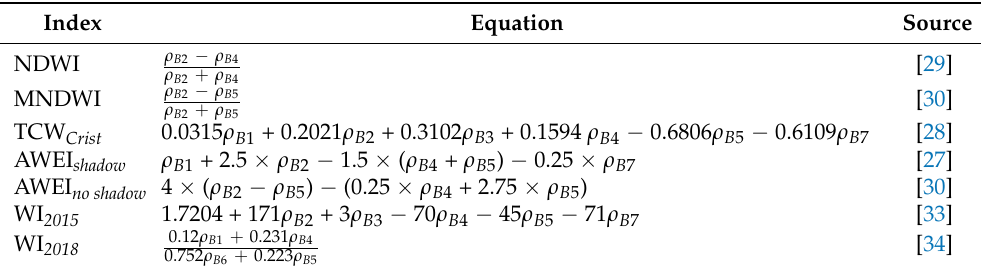
Table 1. Different water indexes defined in literature for water pixel classification using multi-spectral Landsat satellite data. (Surface reflectance values ( ρ ) of the seven bands are indicated as ρ B 1 − ρ B 7 and are the inputs for the